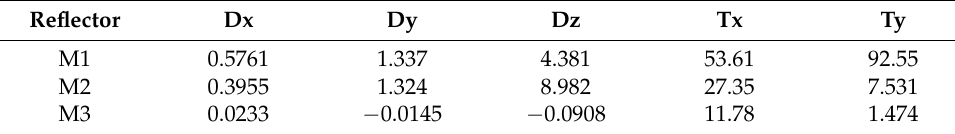
Table 1. Off-axis triple-reverse optical system sensitivity matrix A.